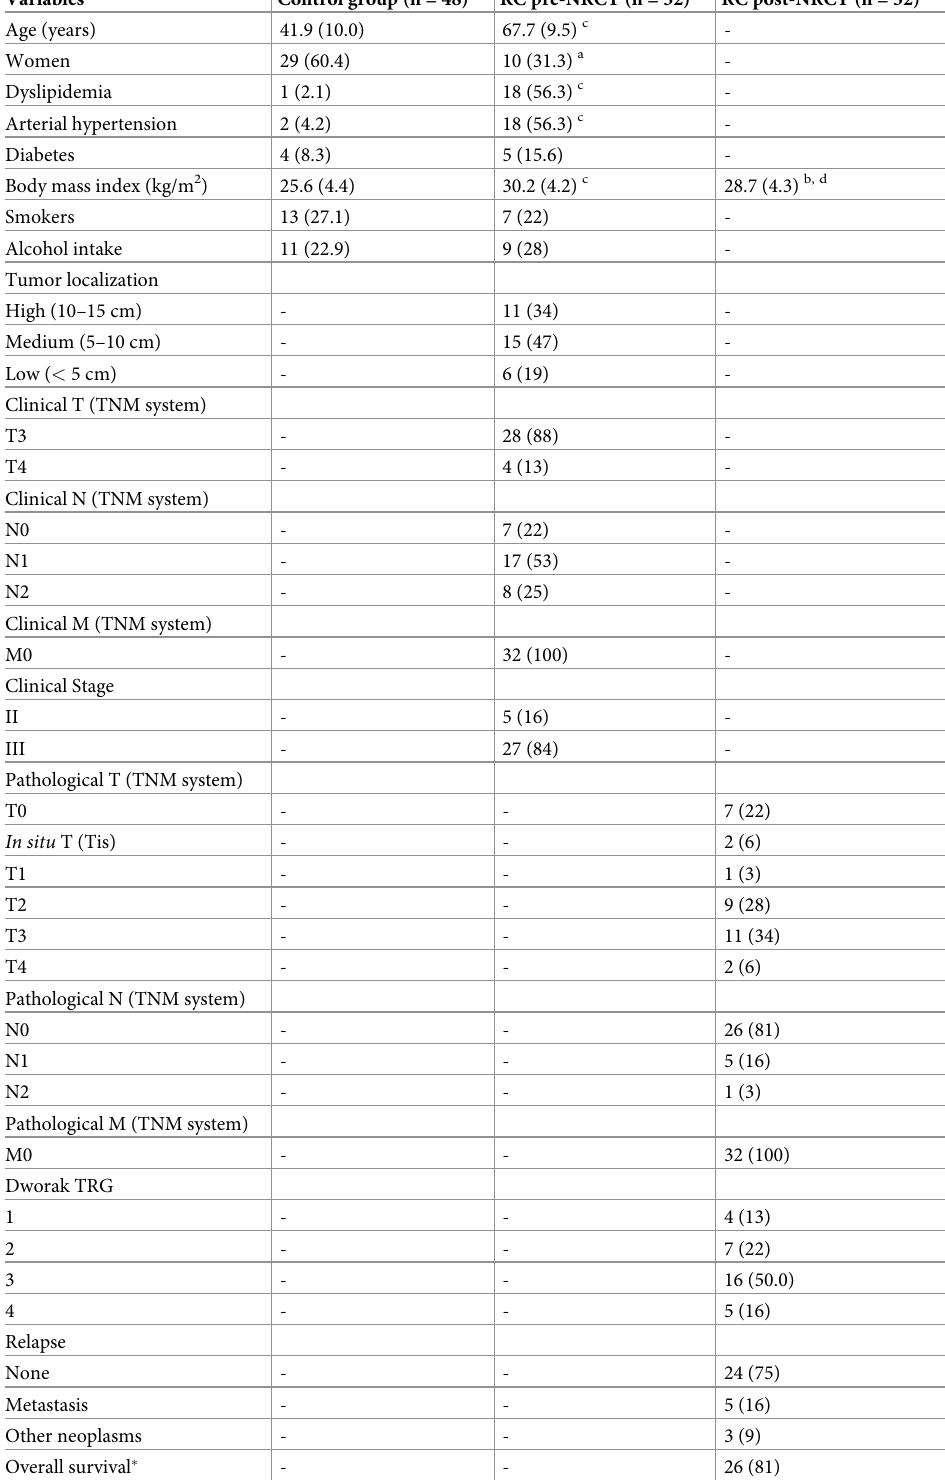
Table 1. Clinical characteristics of the control group and patients with Rectal Cancer (RC), pre- and post-Neoad- juvant Radiochemotherapy